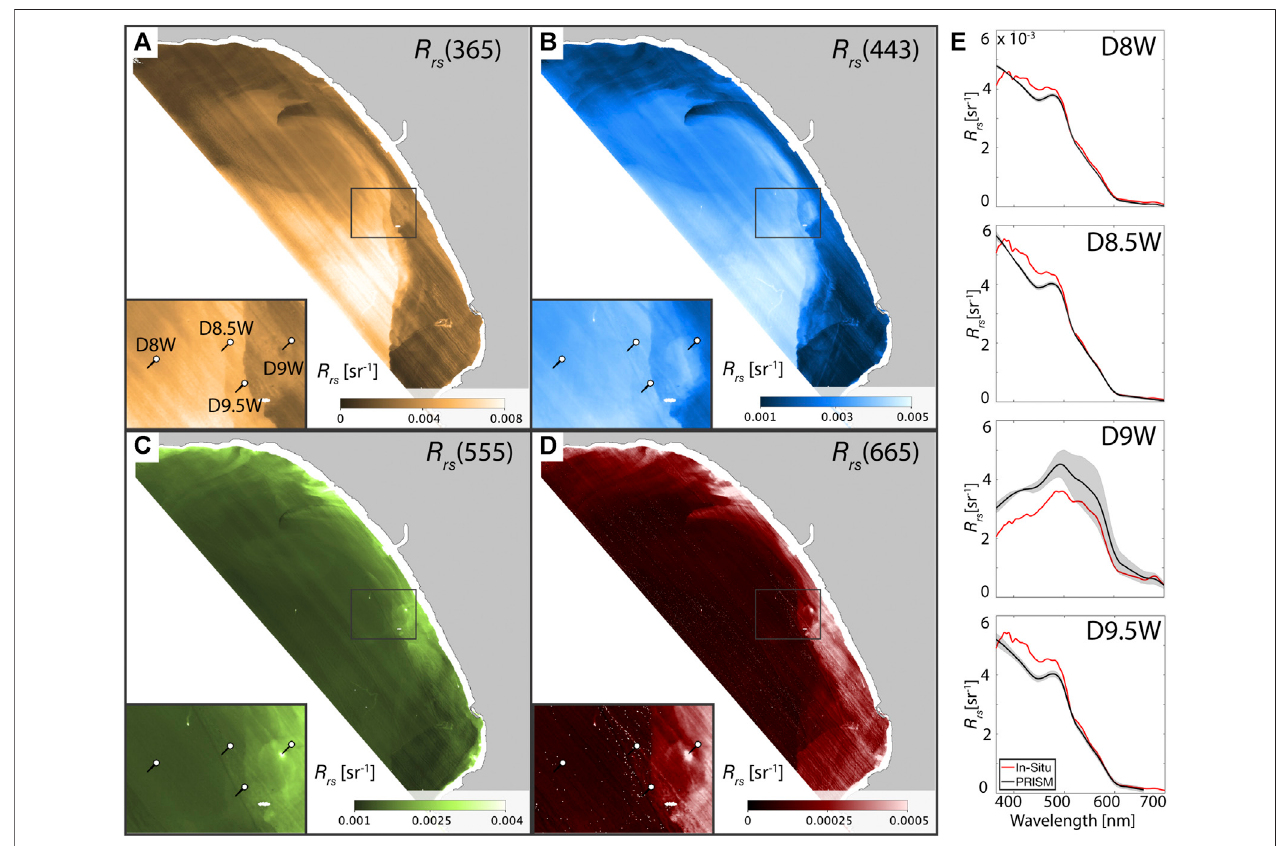
FIGURE 9 | Remote-sensing re fl ectance spectra, R rs ( λ ) , measured by the airborne Portable Remote Imaging SpectroMeter (PRISM) after atmospheric correction (Thompson etal.,2019)during a fl yoverofSantaMonicaBay,CAonOctober26,2015: (A) R rs ( 365 ) map, (B) R rs ( 443 ) map, (C) R rs ( 555 ) map, (D) R rs ( 665 ) map, and (E) comparisonofPRISM-derived R rs ( λ ) spectrawithcoincident R rs ( λ ) spectrameasured insitu withaSatlanticHyperProatfourmatchupstations:D8W,D8.5W,D9W (outfall), and